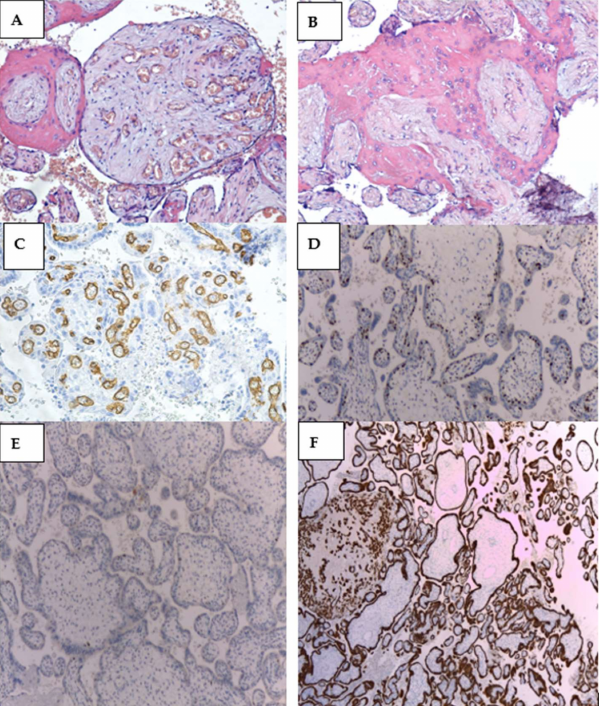
Figure 7. ( A ) Normal placental villi with intravillous vascularity present and villi with absent vascularity with perivillous fibrinoid. Perivillous hematic overflow HE, 200 × ;( B ) Placental villi with absent intravillous vasculature and circumferential perivascular amyloid deposits. Affected syncytiotrophoblast with scattered cells among fibrinoid deposits, HE, 200 × ; ( C ) Normal placental villi, with normal capillary density. Immunohistochemical staining with anti-CD34 antibody (marks capillary endothelium in brown), 200 × ; ( D ) Normal p57 expression in the trophoblast, but absent stromal staining in placental mesenchymal dysplasia, IHC staining with DAB chromogen 10 × ; ( E ) p53 protein expressed in the nuclei of some trophoblastic cells (p53 wild-type pattern), IHC staining with DAB chromogen 10 × ; ( F ). Intense positive cytokeratin 7 staining of the villous trophoblastic cells, IHC staining with DAB chromogen 10 ×